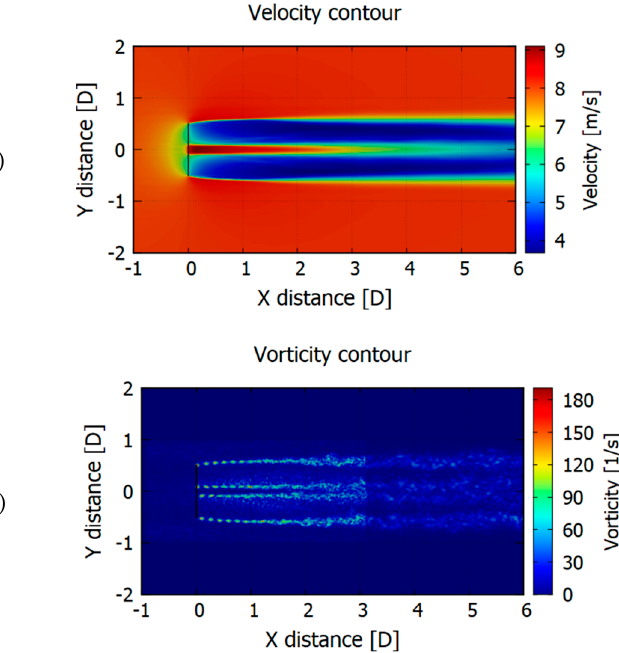
Figure 4. Mean velocity ( a ) and vortices ( b ) contours for Single Rotor Wind Turbine (SRWT) operating with TSR = 5.